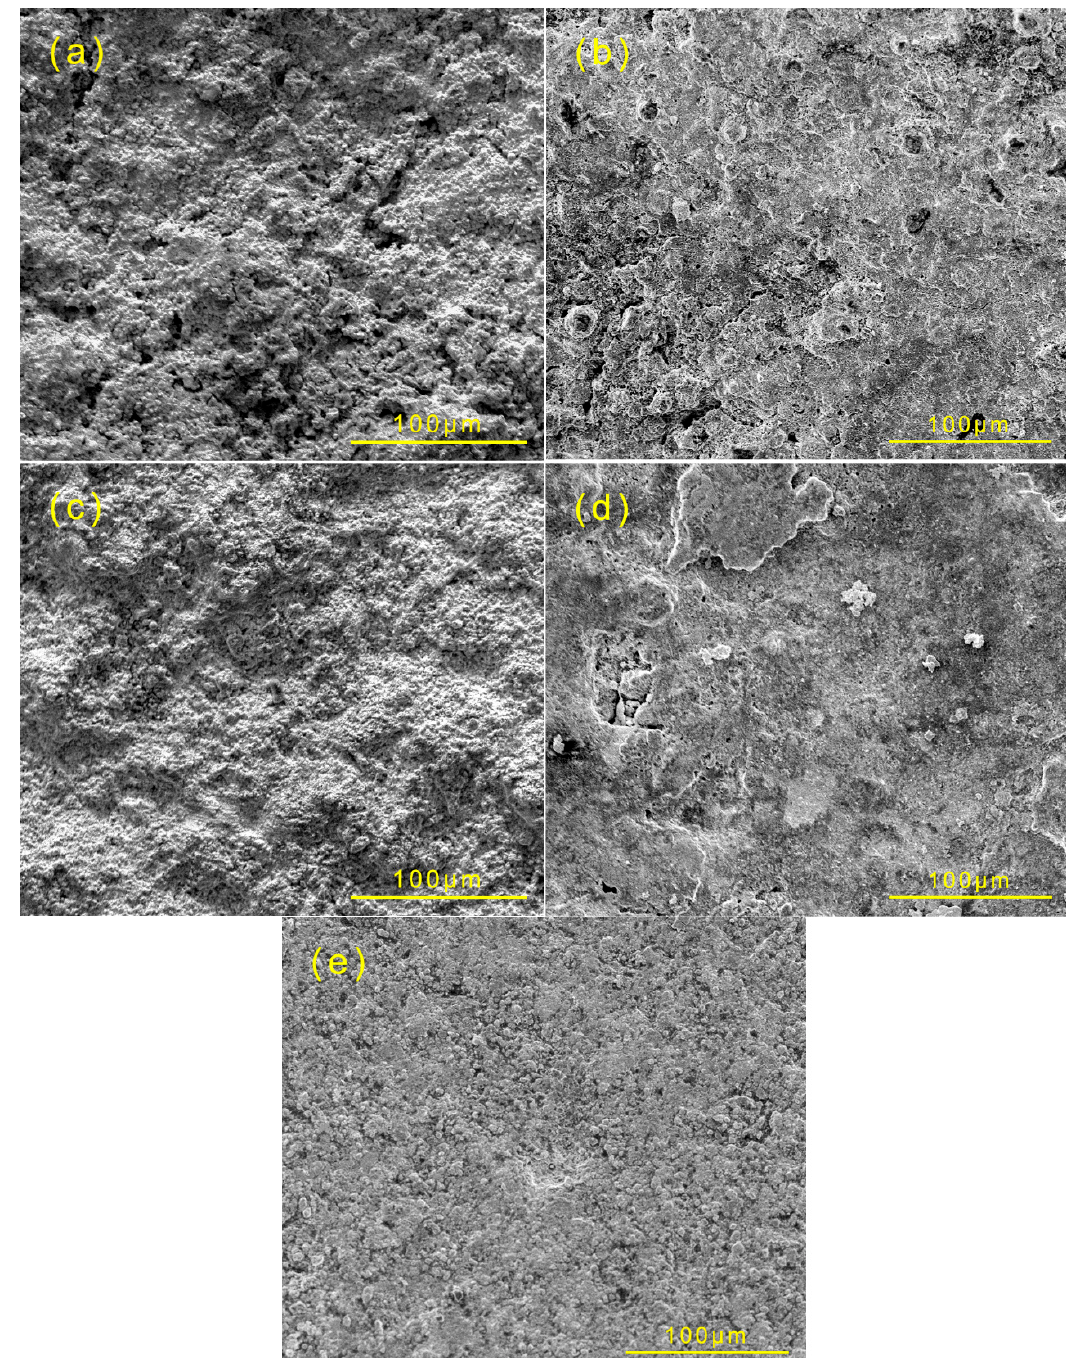
Figure 5. Surface morphologies: ( a ) H1; ( b ) E1; ( c ) H2; ( d ) E2; ( e ) E3.